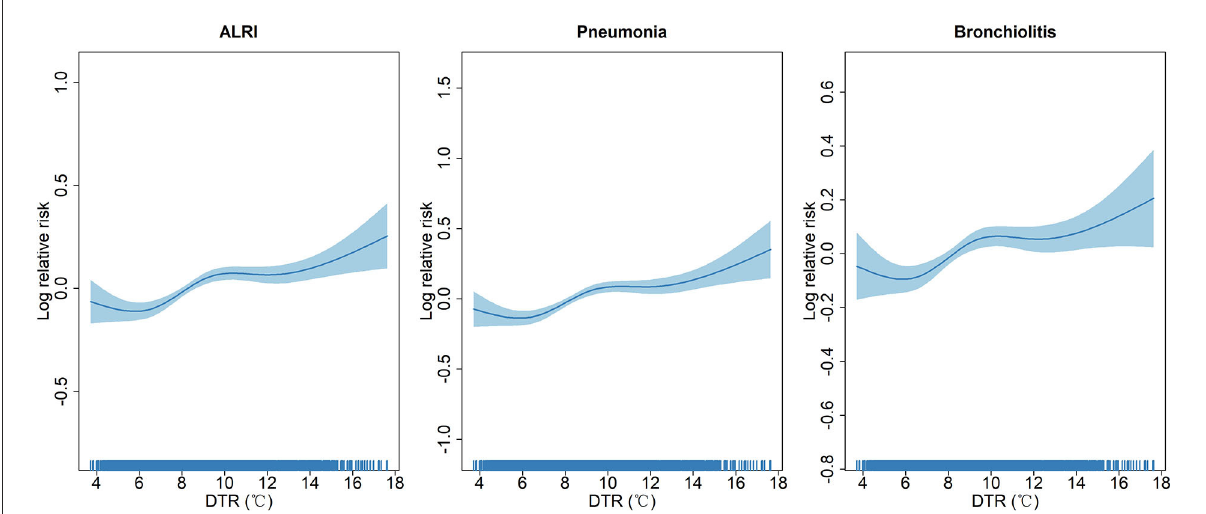
FIGURE2 Concentration-response curves showing the non-linear association between diurnal temperature range and log relative risks of acute lower respiratory infection outpatient visits.